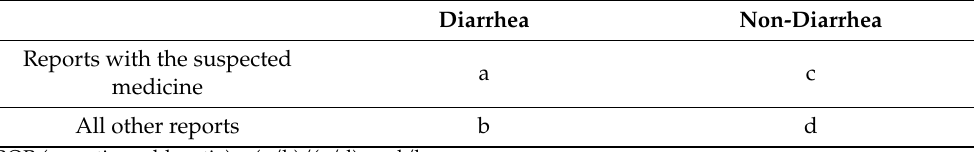
Table 7. Cross-tabulation and calculation formula for RORs of adverse events. Diarrhea Non-Diarrhea Reports with the suspected a c medicine All other reports b